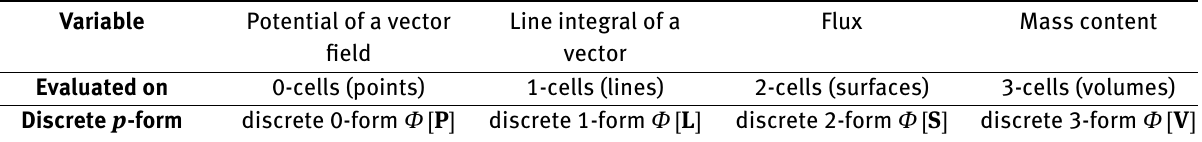
Table 1: Examples of discrete p -forms Variable Evaluated on